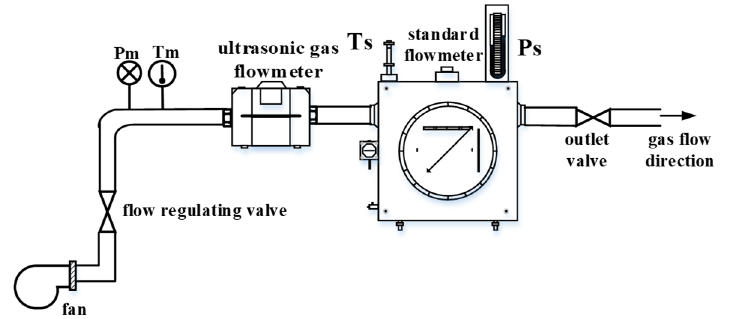
Figure 9. Schematic diagram of the experimental measurement system.